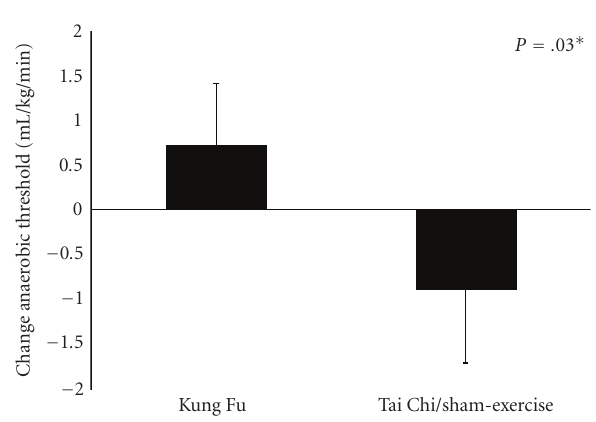
Figure 1: Graph of change in anaerobic threshold (mL · kg − 1 · min − 1 ) after 6 months of Kung Fu or Tai Chi/sham exercise control training (ANCOVA model of change score adjusted for baseline value of anaerobic threshold and attendance rate), with standard error